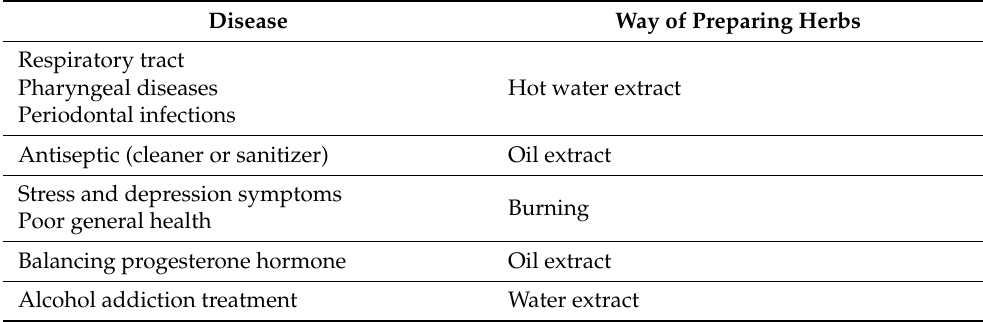
Table 1. Examples of the use of the herb Thymus baicalensis in traditional medicine in Mongolia. Disease Way of Preparing